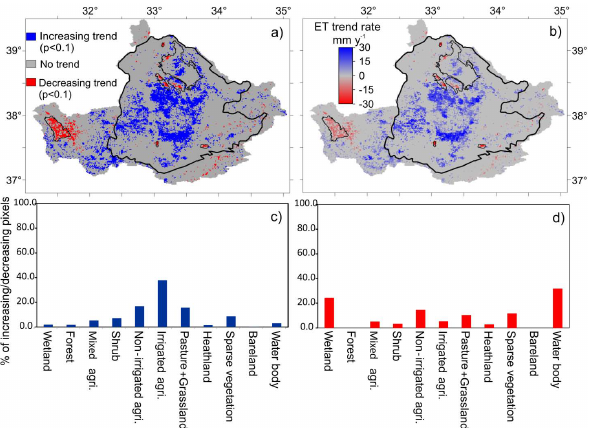
Fig. 6. Distributions of trends in the seasonal ET in the Konya Basin for (a) spring, (b) summer, (c) autumn, (d) winter between 2000 and 2010.